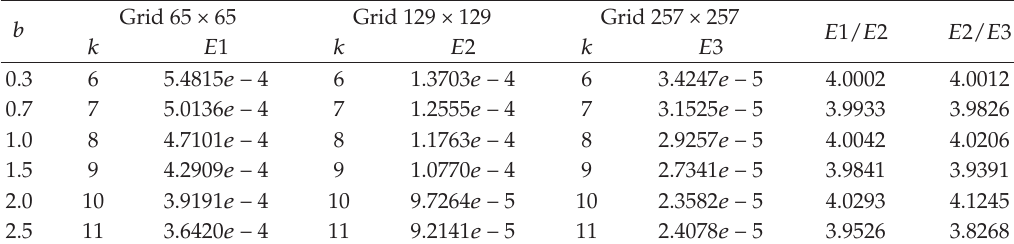
Table 4: Convergence of the method in Example 4.4 for a (cid:10) 0.